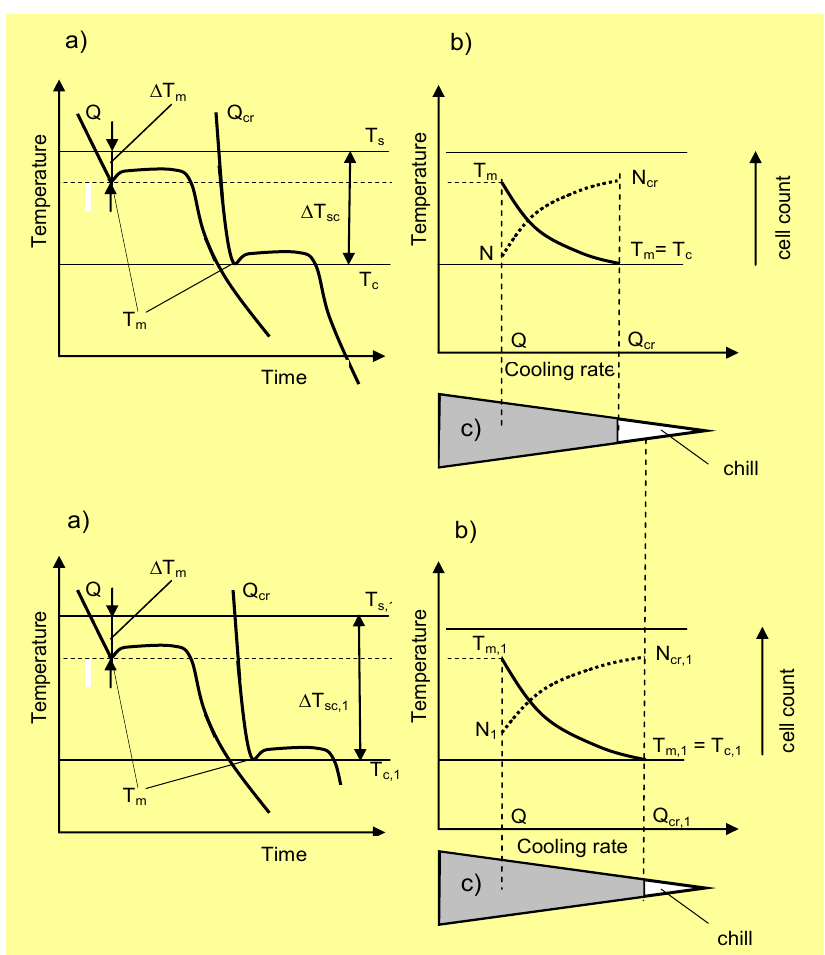
Figure 3. ( a ) Cooling curves and ( b ) effect of the cooling rate, Q, along the wedge axis on minimum solidification temperature, T m , eutectic graphite and eutectic cell count, N , for two cast irons with different physical-chemical properties. ( c ) Scheme of a wedge section containing a